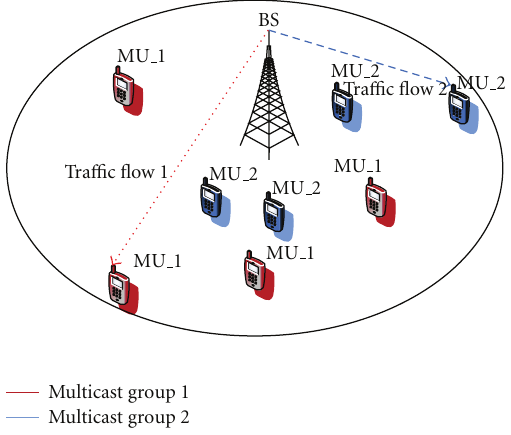
Figure 1: Multiple users demand the same data